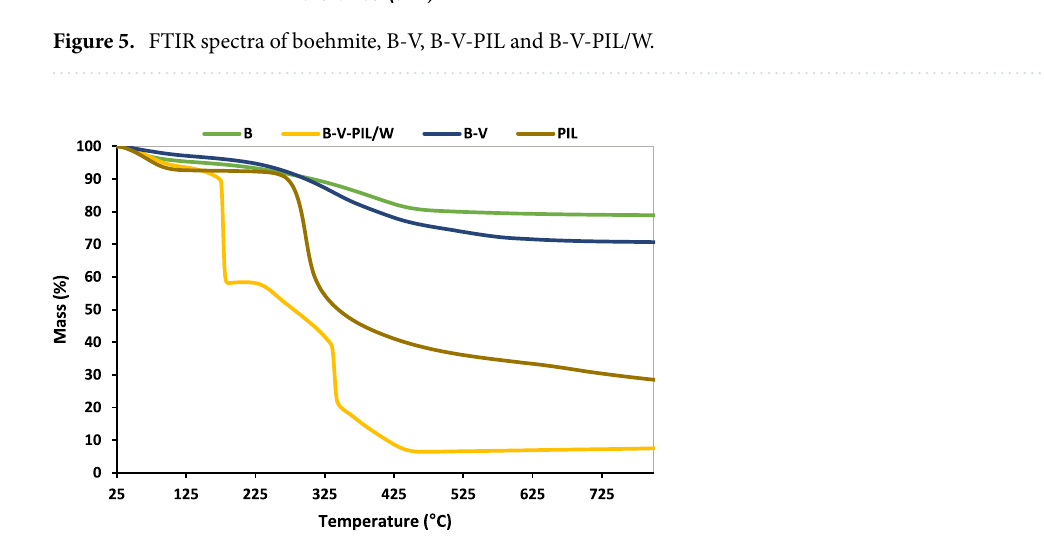
Figure 6. TG curves of boehmite, B-V, PIL and